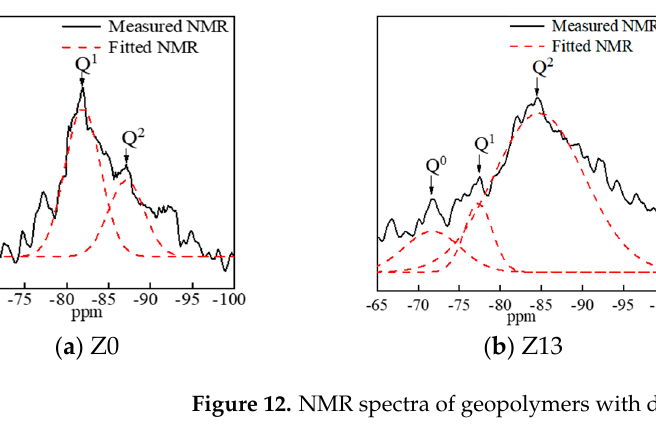
Figure 12. NMR spectra of geopolymers with different ratios.